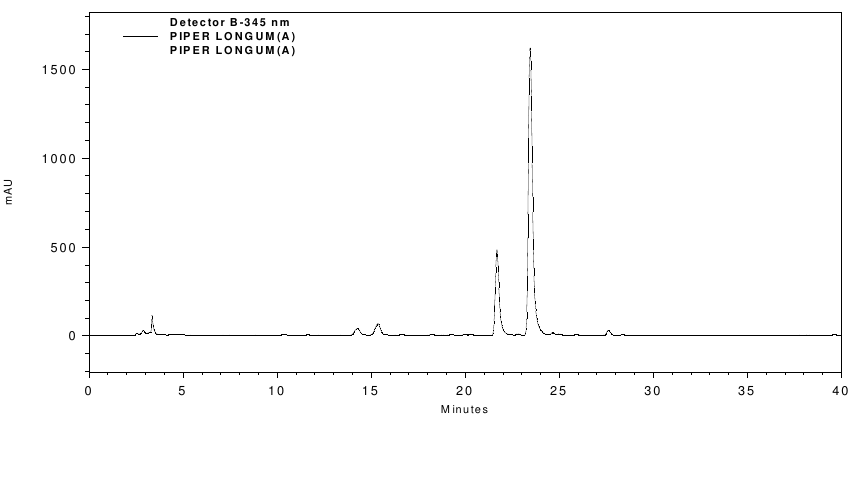
Figure 2. HPLC chromatogram of fruit of Piper longum